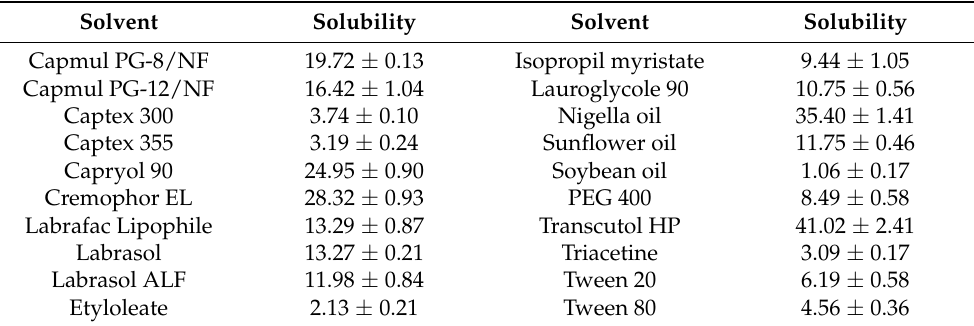
Table 1. Saturation solubility (mg/mL) of oleanolic acid in different oils and surfactants.